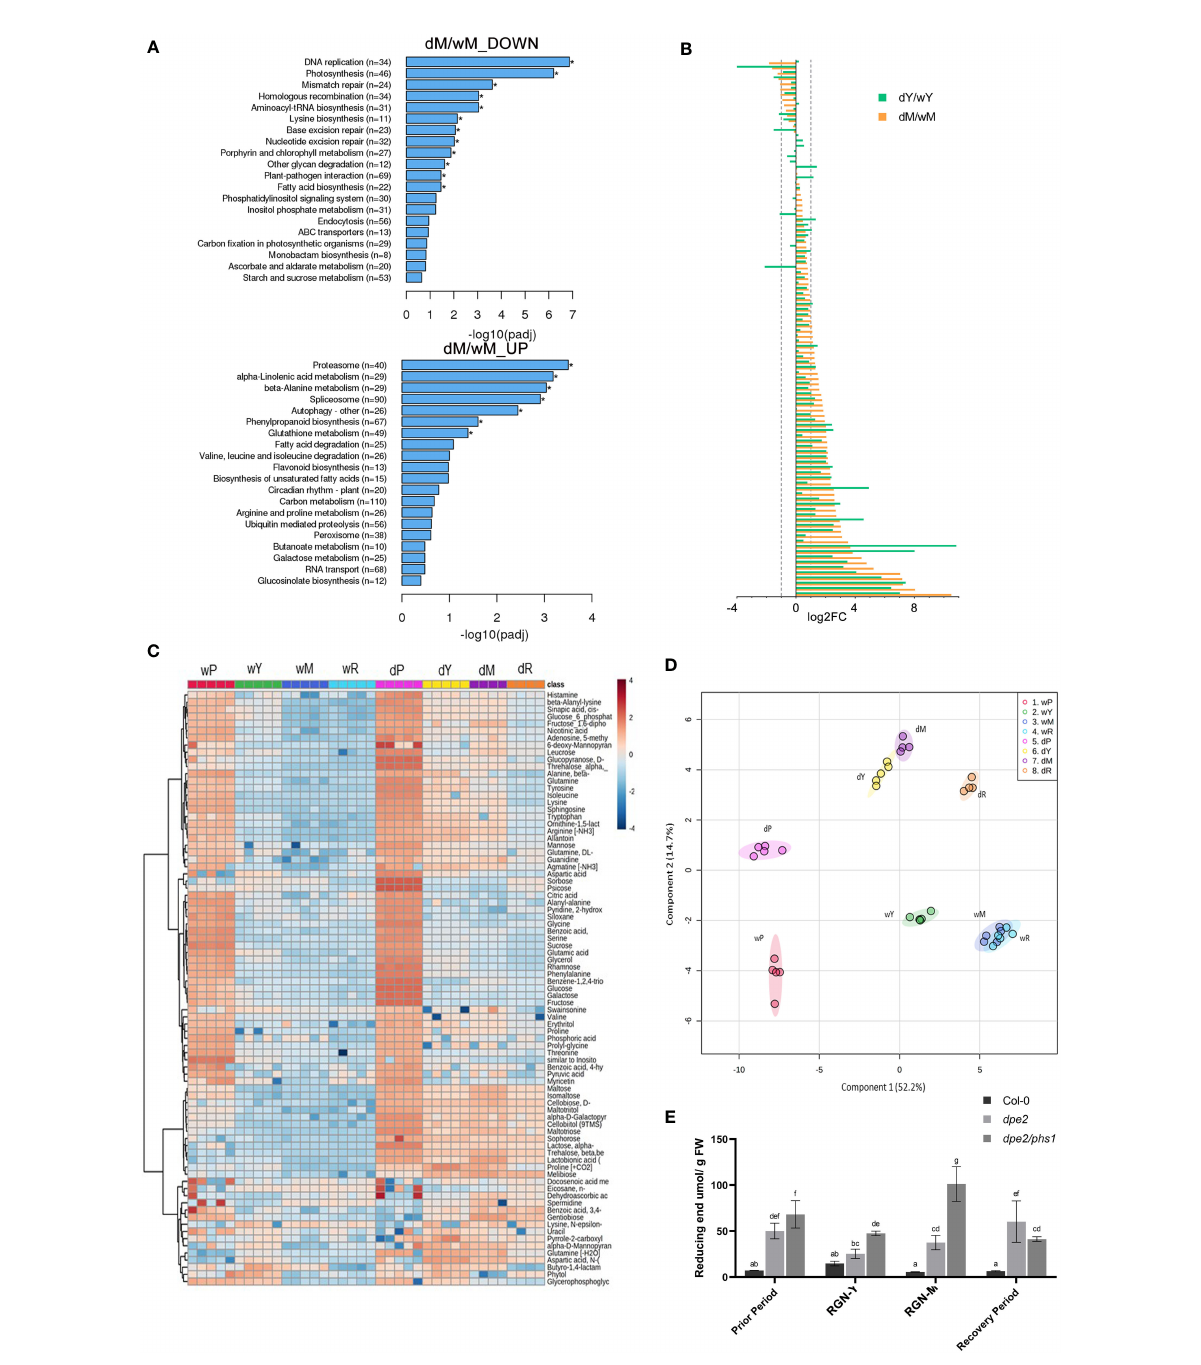
FIGURE 6 Signi fi cantly differentially regulated pathways in dpe2/phs1 mature leaves and metabolic pro fi ling: (A) KEGG bar charts indicating the pathways differentially regulated between dpe2/phs1 and Col-0 mature leaves; (B) Changes in expression of 105 senescence-related genes. The difference between the young leaves of dpe2/phs1 compared to age-matched leaves of Col-0 (dY/wY), and the mature leaves of dpe2/phs1 compared to age-matched leaves of Col-0 (dM/wM) are shown. (C) Heatmap analysis showing selected metabolites; (D) Partial least squares discriminant analysis (PLS-DA) results showing the sample clusters. A minimum of four biological replicates is presented for each. Values are expressed as concentrations normalized to median values; (E) Maltodextrin content. All values are mean ± SD (n = 3 replicates from a mixture of 8 – 10 plants each harvested after 9 hours of illumination). Letters indicate statistically signi fi cant differences (p ≤ 0.05) according to one-way ANOVA with Duncan ’ s post-hoc